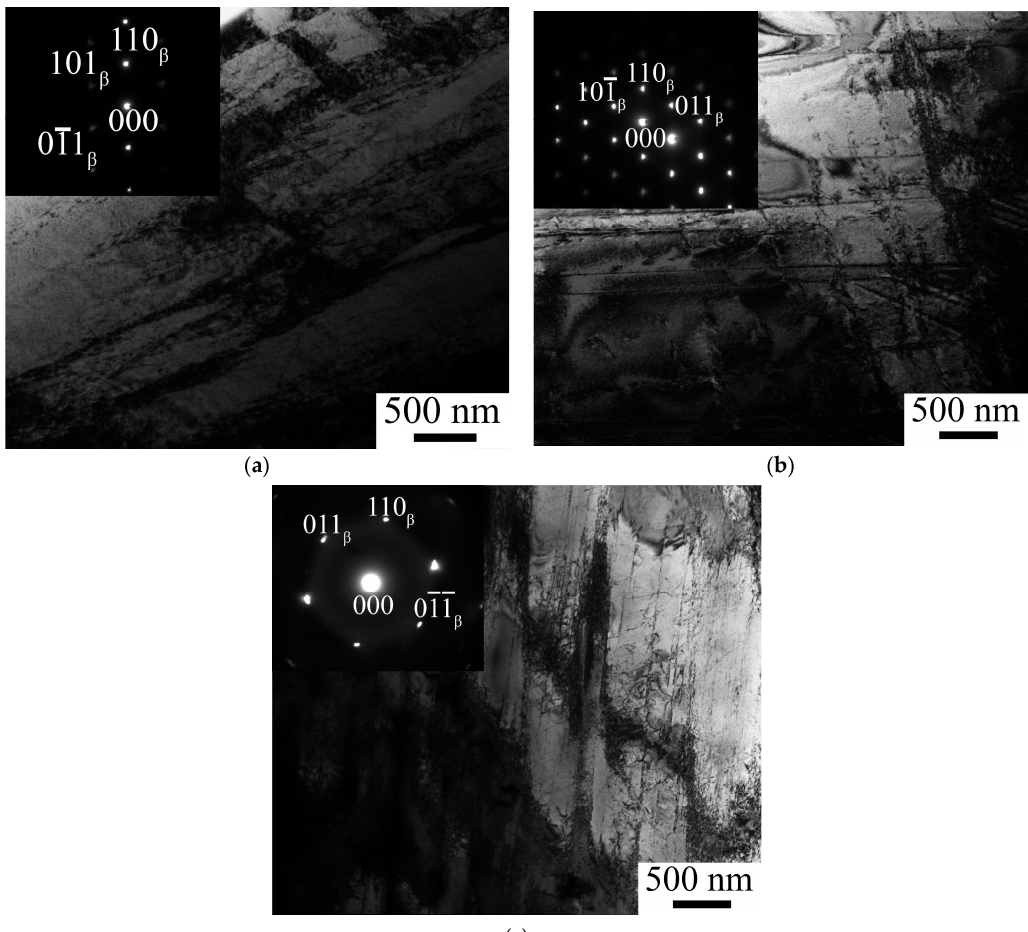
Figure 5. TEM images of deformed microstructures near the fracture surfaces of specimens after tensile tests: ( a )—Ti30Nb20, ( b )—Ti40Nb10, ( c )—Ti50Nb0.